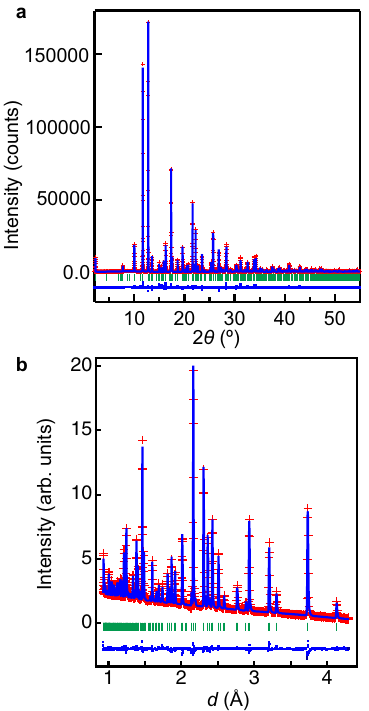
Fig. 5 | Rietveld fi tting patterns of Ba 7 Nb 4 MoO 20 ·0.15 H 2 O. a Resonant X-ray diffraction(RXRD)datameasuredat297Kwith0.6527887(5)ÅX-rayattheBL02B2 beamline. b Neutron diffraction data at 300K. The observed and calculated intensities and difference plots are shown by red cross marks, blue solid lines, and blue dots, respectively. Green tick marks denote the calculated Bragg peak positions.